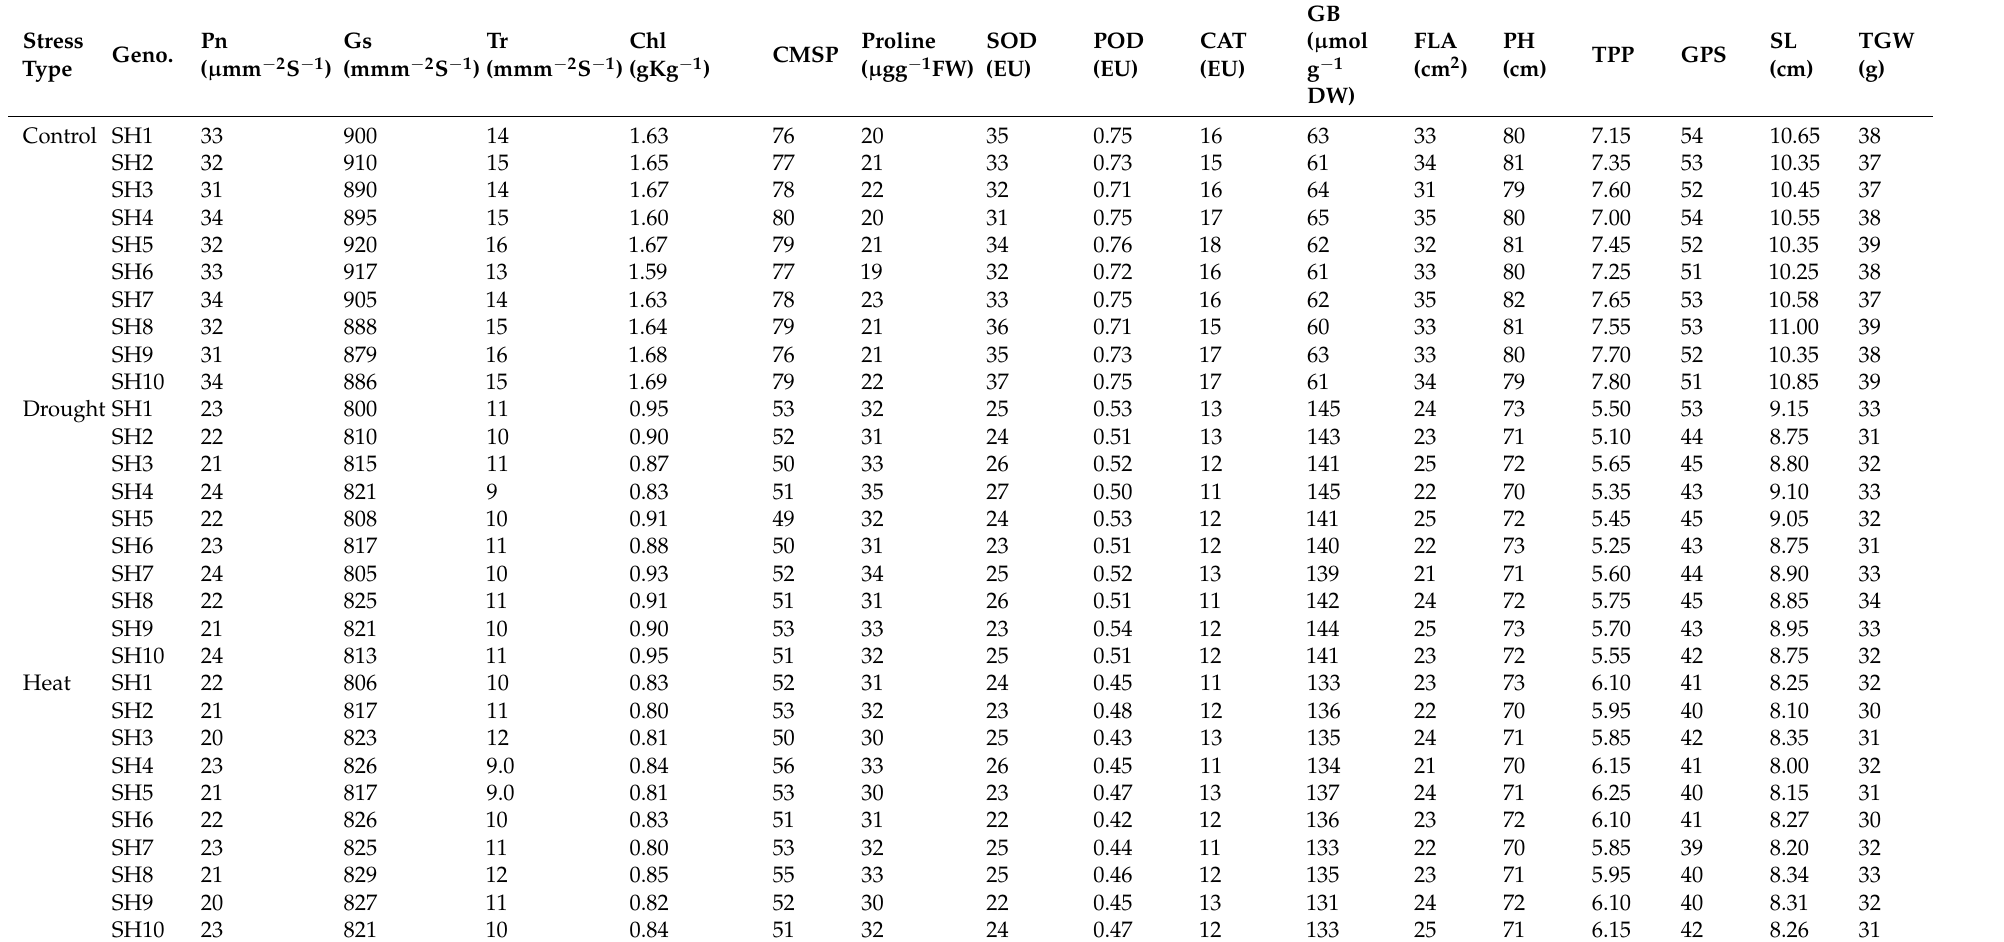
Table 6. Variation in physiological, biochemical, and agronomic traits (averaged 2020–21 and 2021–22) due to interaction effect of synthetic hexaploid wheat genotypes with individual and combined applications of drought and heat